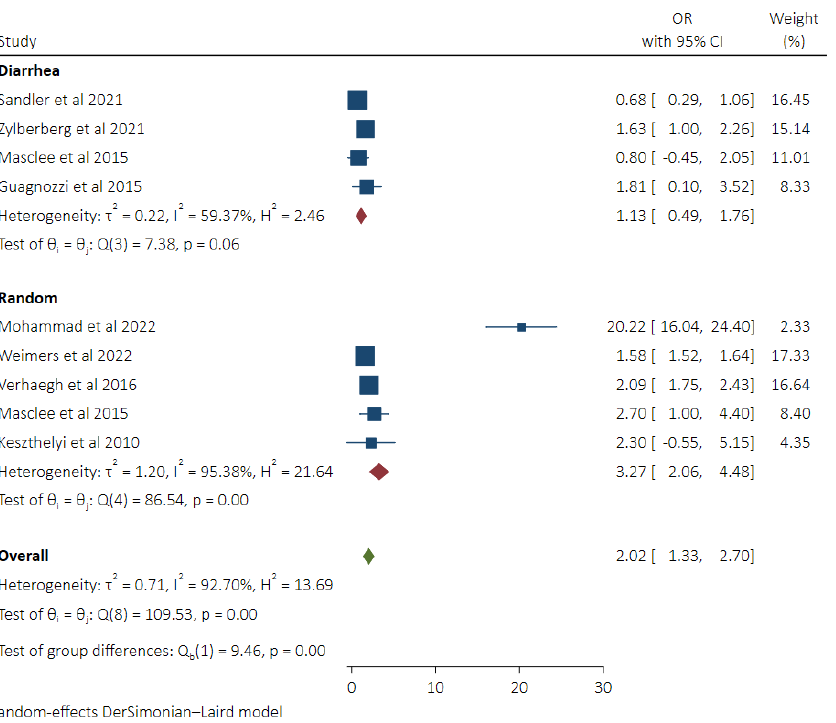
Figure 4. Pooled odds of MC in NSAIDs users with subgroup analysis based on control groups (Diarrhea vs. Random Control) [8,9,12,13,17–19,21]. 3.5. Pooled Odds of MC in Patients Taking Statins with Subgroup Analysis of Diarrhea Versus Random Controls Pooled odds of MC in statin users were 1.74 (95% CI 1.19–2.30, I 2 96.36%) calculated from 9 adjusted odd ratios obtained from 7 studies [8,9,17–19,21,22]. Higher odds of MC